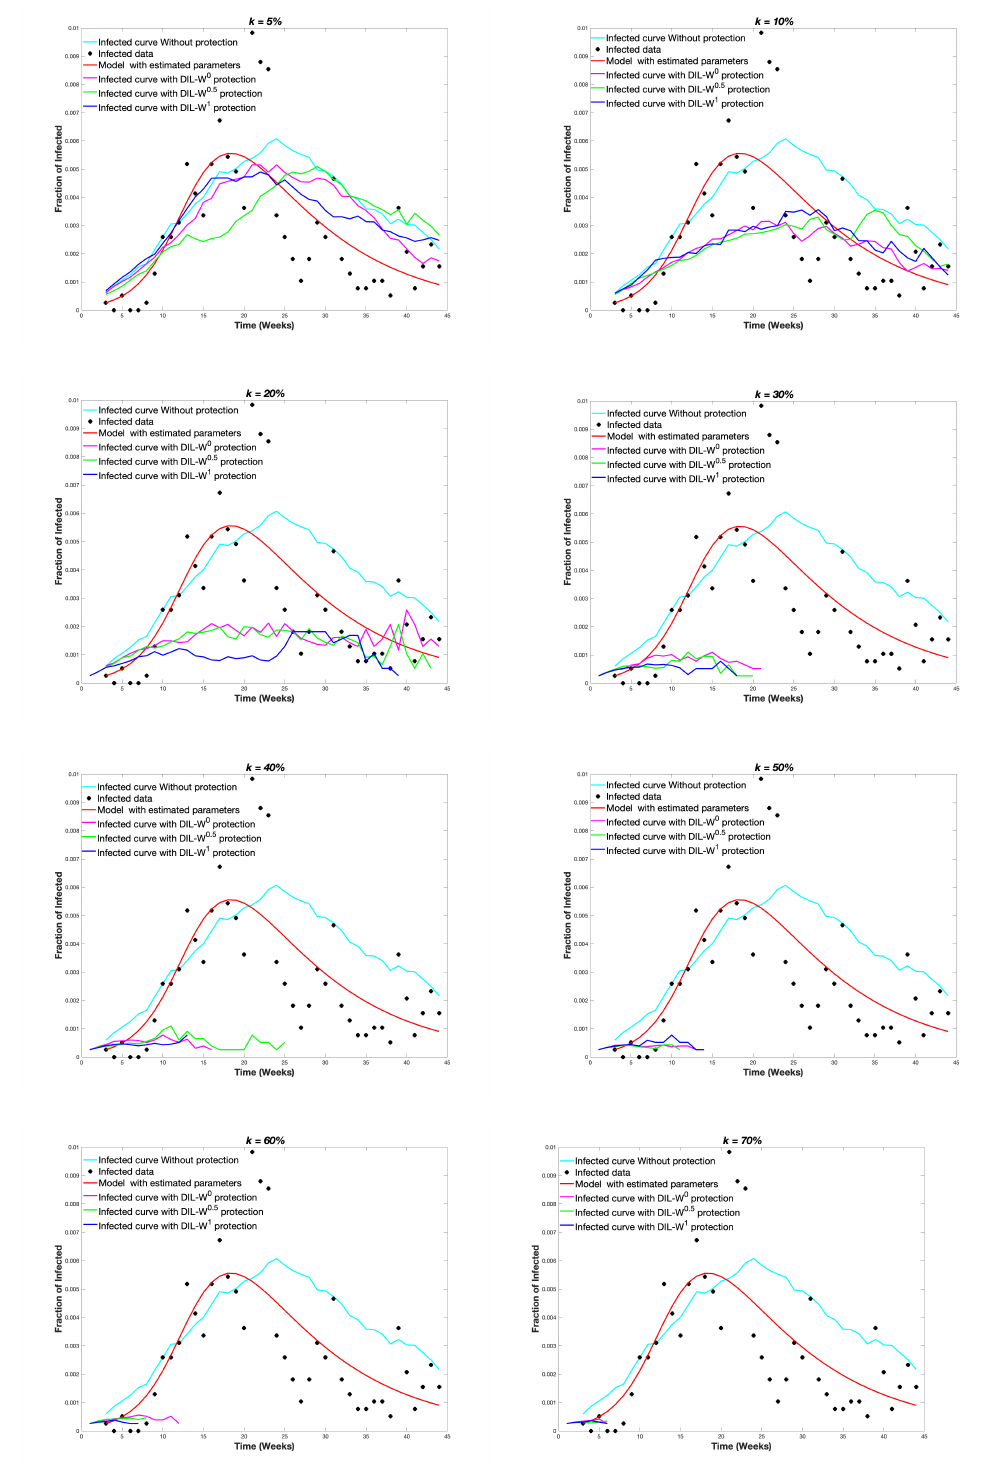
Figure 8. Infected curves obtained according to different values of k